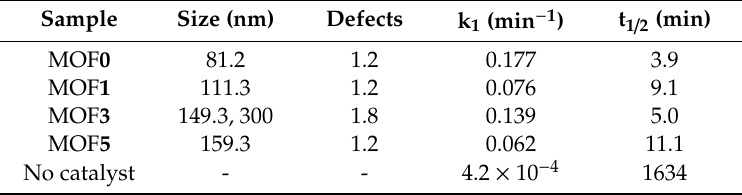
Figure 6. ( A ) Hydrolysis reaction for DMNP using MOF 0 as a catalyst, ( B ) conversion for the hydrolysis of DMNP in the presence of MOF 0 , MOF 1 , MOF 3 , and MOF 5 or without catalysts. Table 1. Catalytic performance of obtained products for degrading the nerve agent Simulant DMNP. Sample